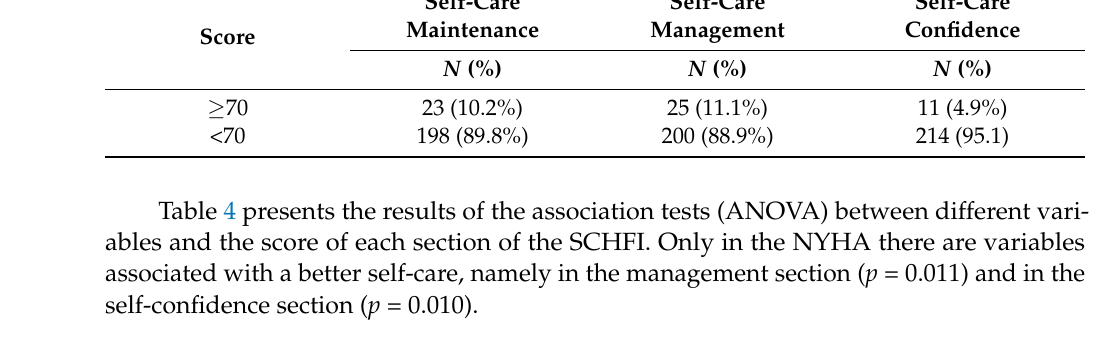
Table 4. Association tests between different variables and the score of each section of the Self-Care Heart Failure Index